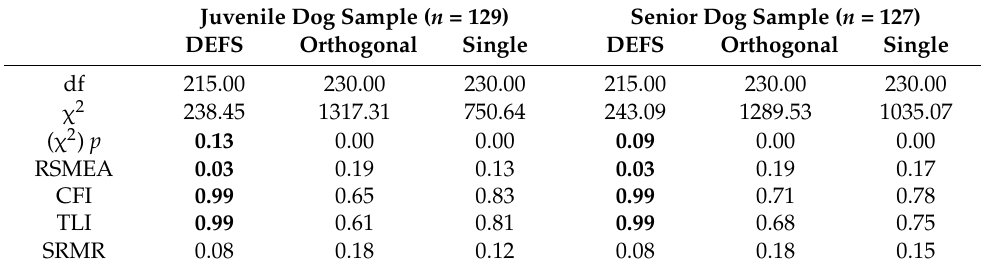
Table 1. Fit indices for models using juvenile and senior dog data. DEFS Model = Oblique model with 6 latent factors, Orthogonal Model = Orthogonal model with 6 latent factors, Single Model = Model with single latent factor for executive function. Values that indicate good model fit are bold. Juvenile Dog Sample ( n = 129) Senior Dog Sample ( n = 127) DEFS Orthogonal Single DEFS Orthogonal